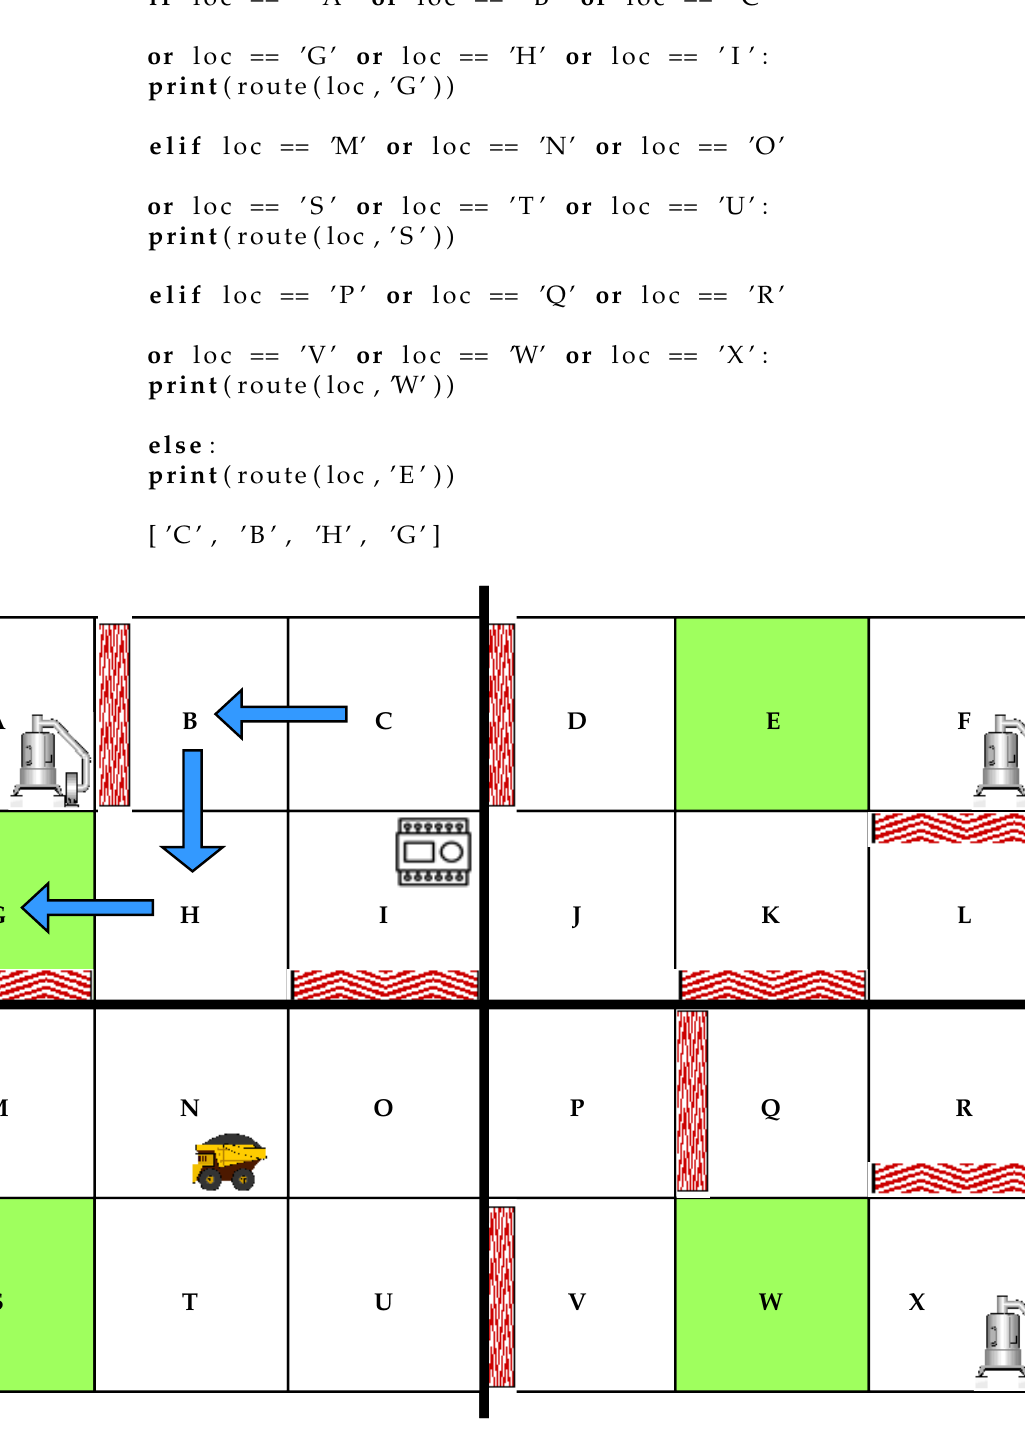
Figure 6. Graphical robot selected path from C to safety exit G